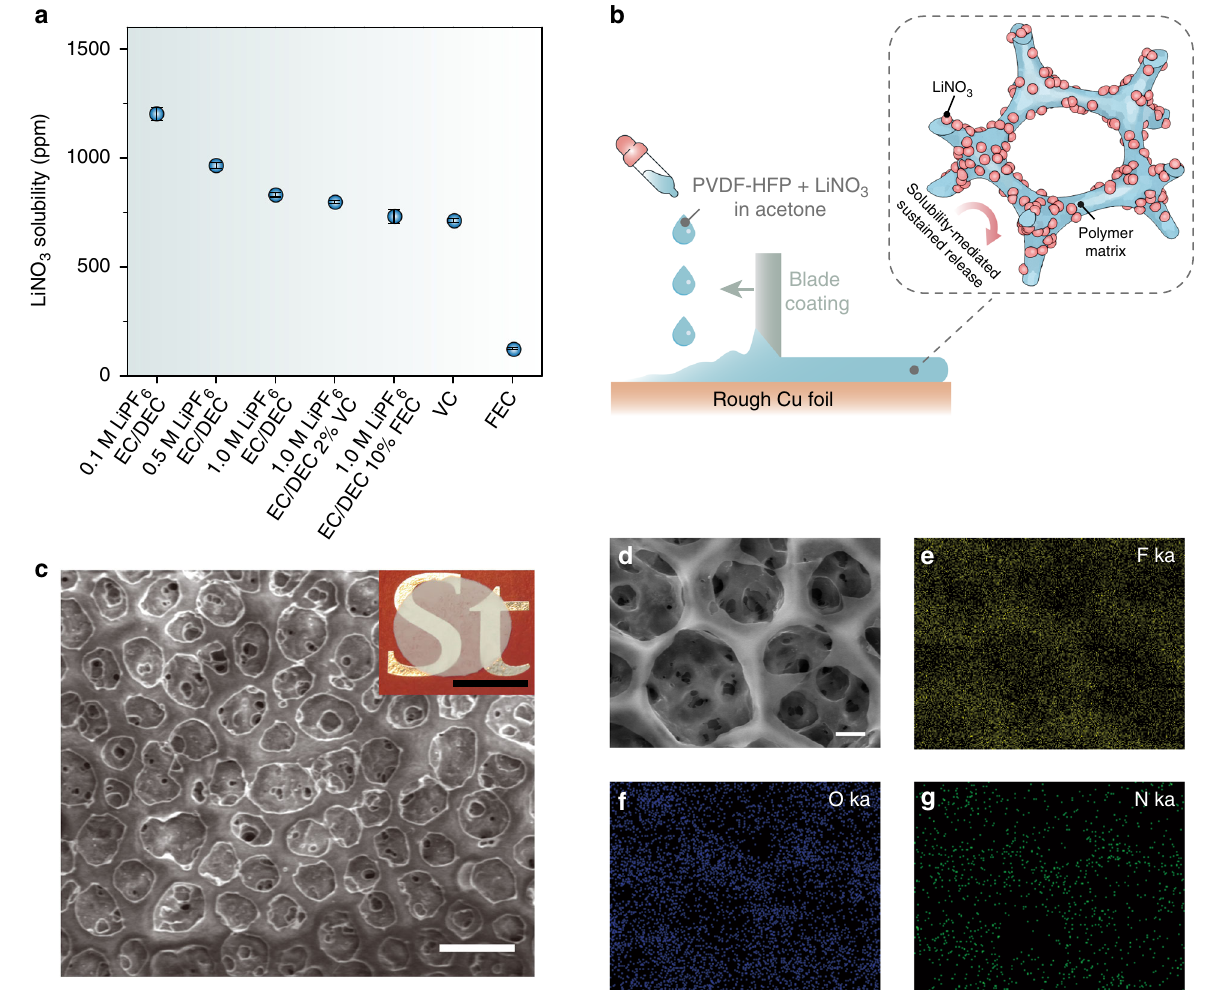
Fig. 2 Fabrication of the solubility-mediated sustained-release fi lm. a Solubility of LiNO 3 in EC/DEC-based electrolytes with different LiPF 6 concentrations and additives, in pure VC and in pure FEC. b Schematic illustrating the fabrication and working principle of LNO-SRF. c Top-view SEM image and photo image (inset) of LNO-SRF. Scale bar, 5 μ m and inset scale bar, 1 cm. d High-magni fi cation SEM image and e – g the corresponding EDX elemental mappings of LNO-SRF. Scale bar, 2 μ